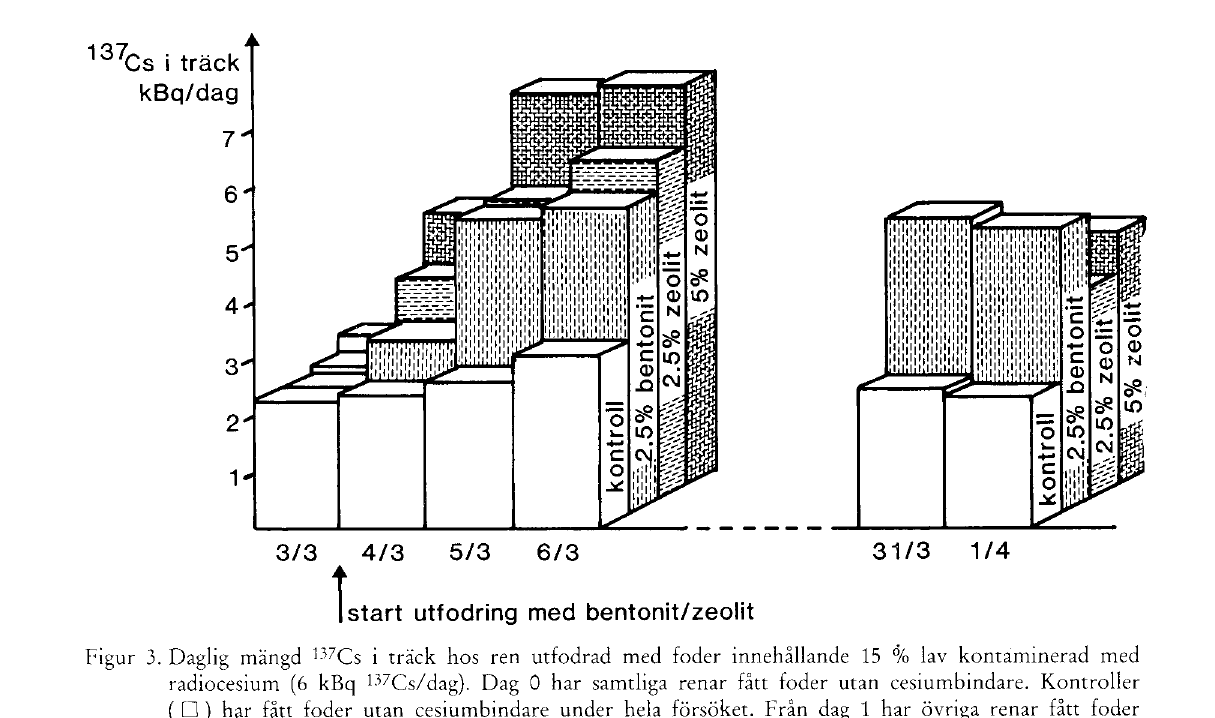
Figur 3. Daglig mångd 137 Cs i track hos ren utfodrad med foder innehållande 15 % lav kontaminerad med radiocesium (6 kBq 137 Cs/dag). Dag 0 har samtliga renar fått foder utan cesiumbindare. Kontroller